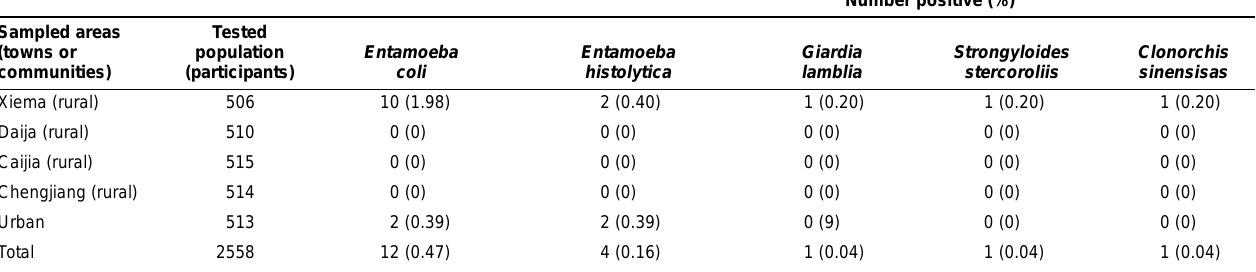
TABLE 1B Infectious rates of different parasitic species in Beibei,